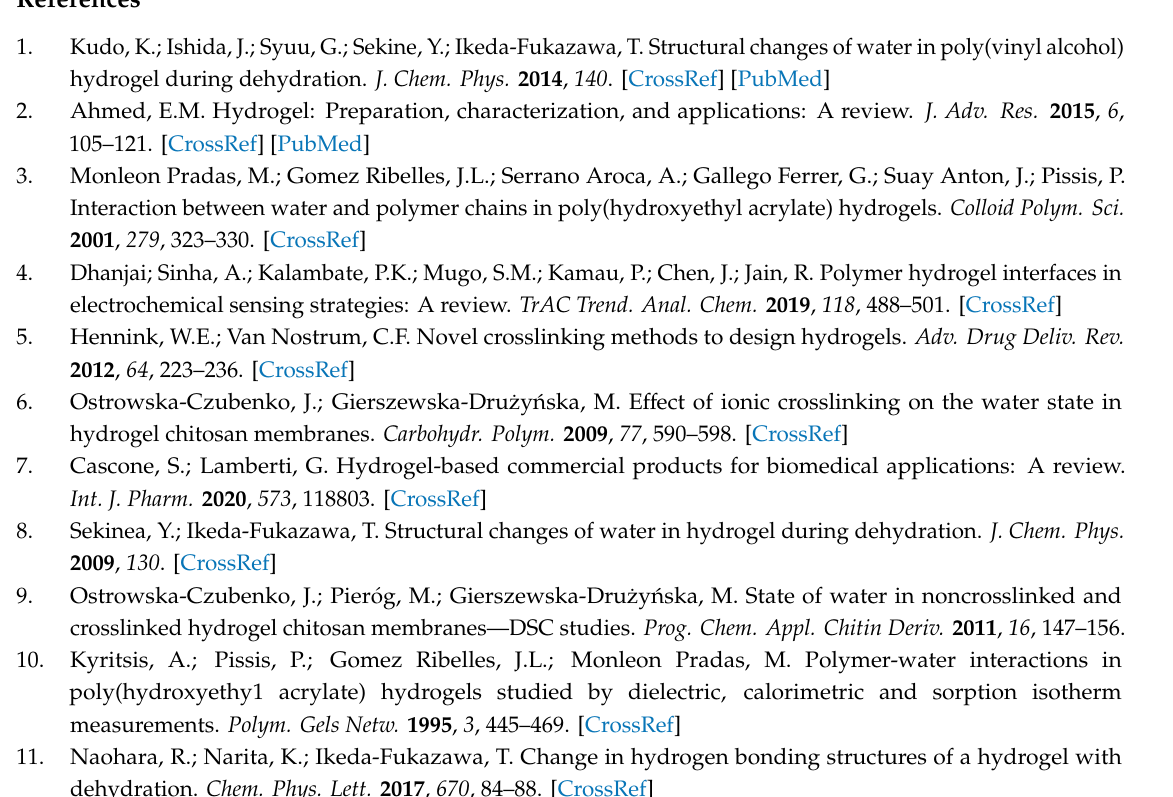
Table S1: T 1 and T 2 relaxation times: values for maximal amplitude and geometric mean (log-mean), Table S2: Di ff usion coe ffi cients of water molecules and viscosities of the samples calculated on the base of di ff usion results. Author Contributions: All authors discussed and agreed upon the idea, and made scientific